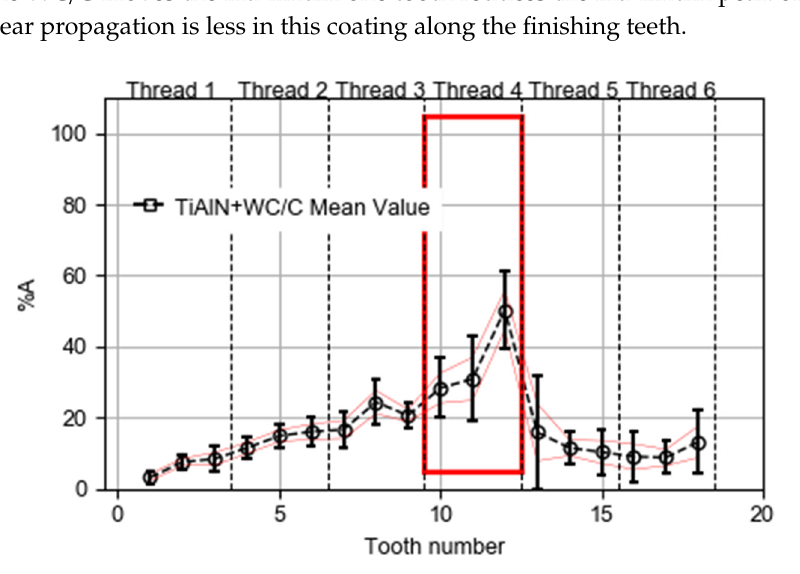
Figure 19. Evolution of mean %A on the teeth of TiAlN+WC/C coated taps.